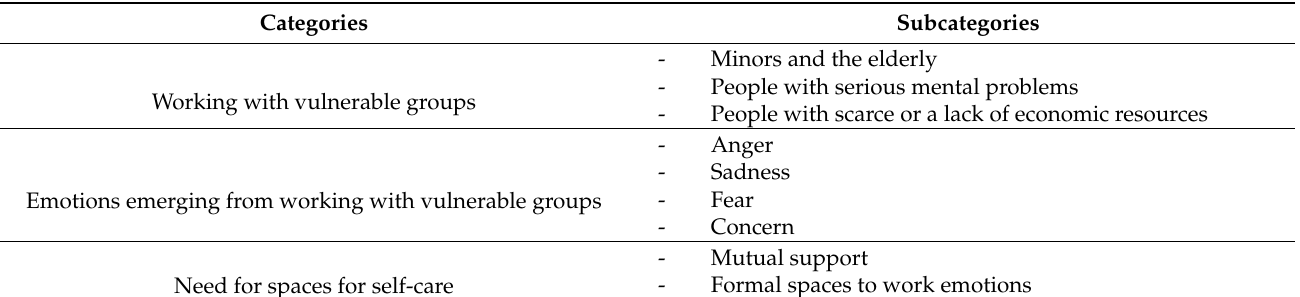
Table 2. Categories and subcategories emerging from the